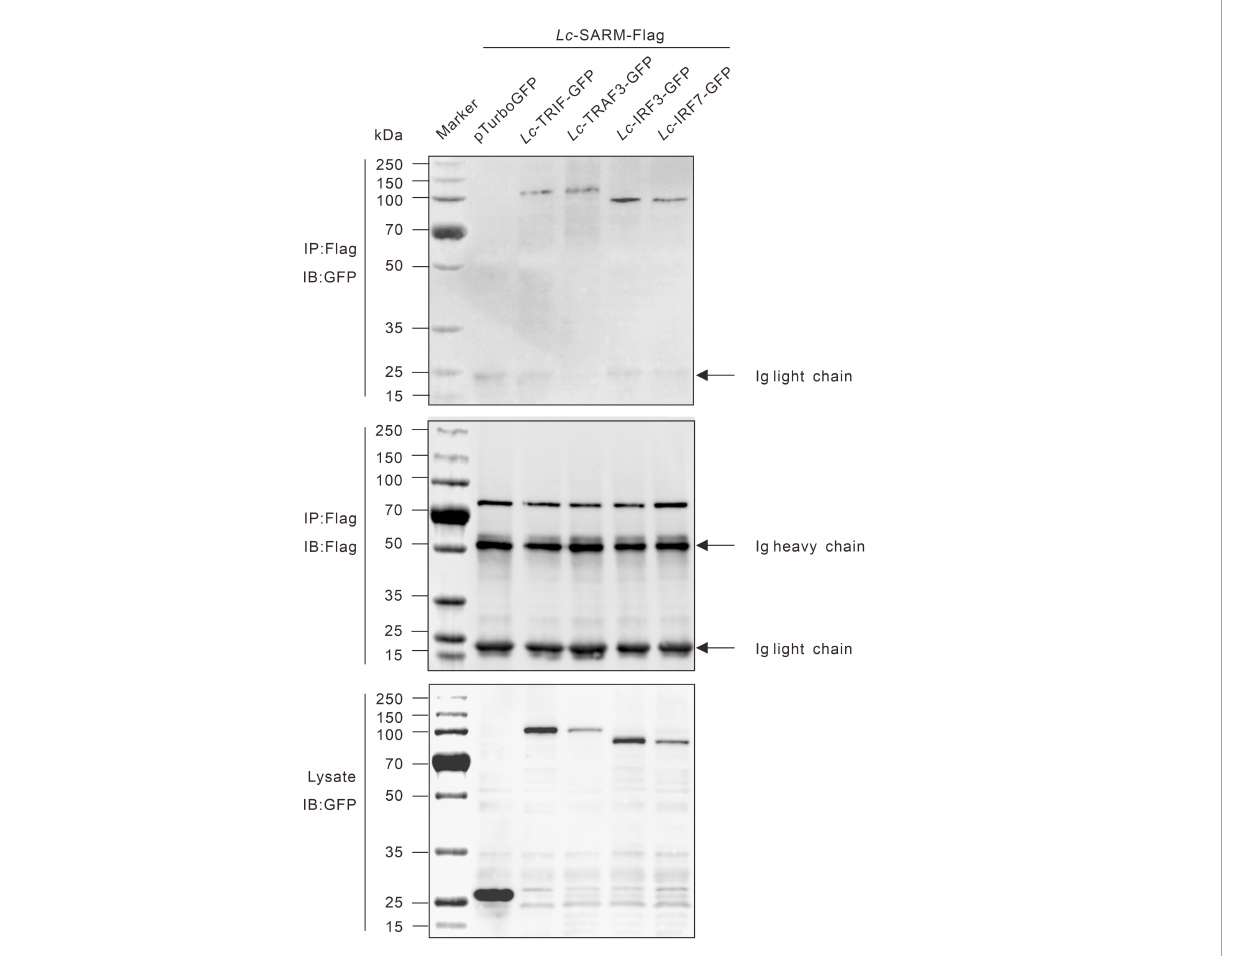
FIGURE 10 Interaction of Lc -SARM with Lc -TRIF, Lc -TRAF3, Lc -IRF3, and Lc -IRF7. HEK 293T cells seeded in 6-well plates (1 × 10 6 cells/well) were co-transfected with 2.5 m g of p3xFLAG-SARM together with 2.5 m g of pTurbo-TRIF-GFP, pTurbo-TRAF3-GFP, pTurbo-IRF3-GFP, pTurbo-IRF7-GFP, or pTurboGFP-N (vector control) in a combination of two. At 24 hpt, the cells were collected and lysed, and the cell lysates were immunoprecipitated with Anti-Flag antibody (covalently conjugated to agarose beads) and immunoblotting with Anti-TurboGFP antibody (upper panels). The Lc -SARM-Flag bound to Anti- Flag-agarose beads was shown by immunoblotting with Anti-Flag antibody (middle panels), and the cells lysates were also detected by immunoblotting with Anti-TurboGFP antibody (bottom panels), respectively.